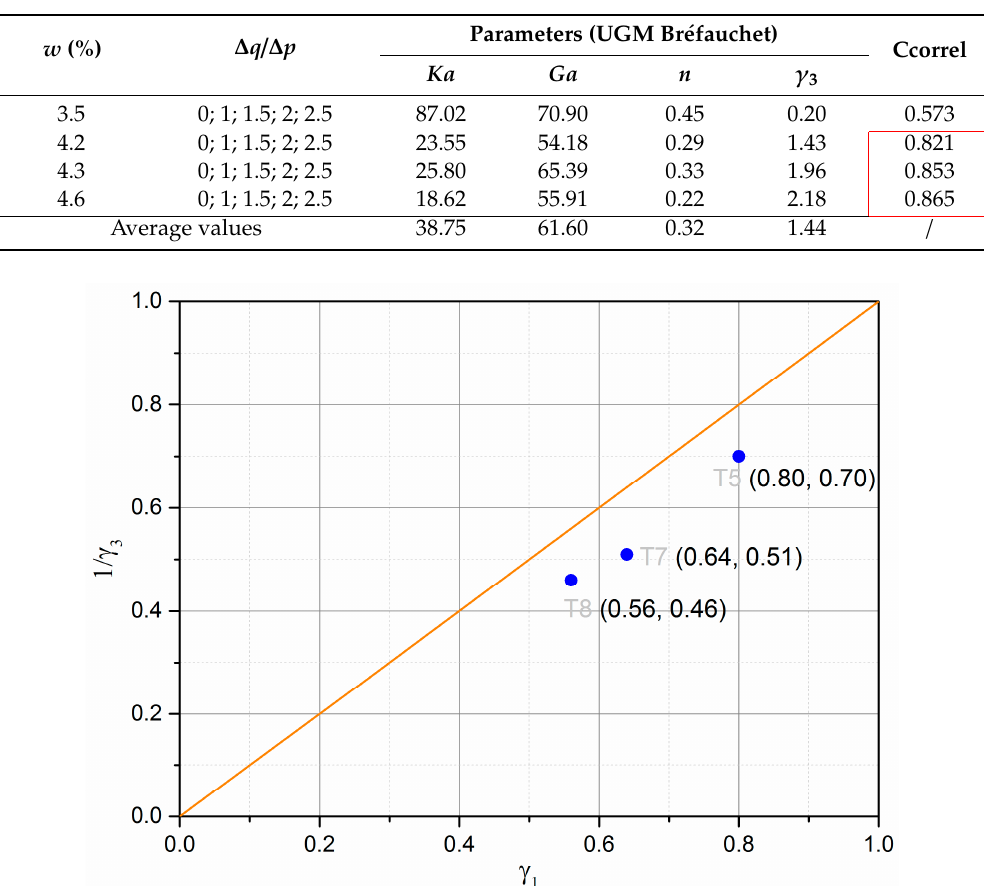
Table 6. Parameter optimization of Equations (12)–(15) for UGM Br é fauchet with γ 3 .